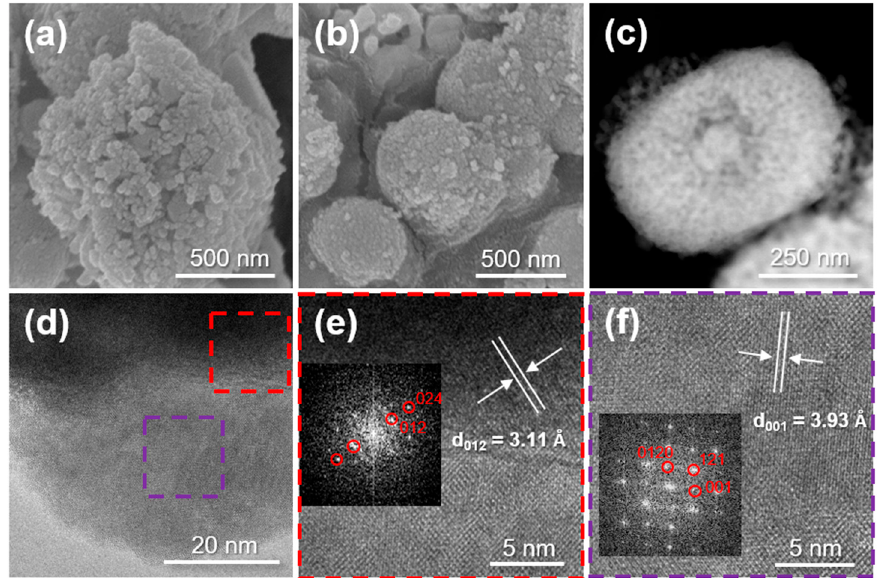
Figure 4. ( a ) FE-SEM image of the composite before heat treatment (as-prepared sample) and ( b ) FE-SEM image, ( c ) bright-field TEM image, and ( d–f ) HR-TEM images of the composite after heat treatment (inset: FFT patterns).